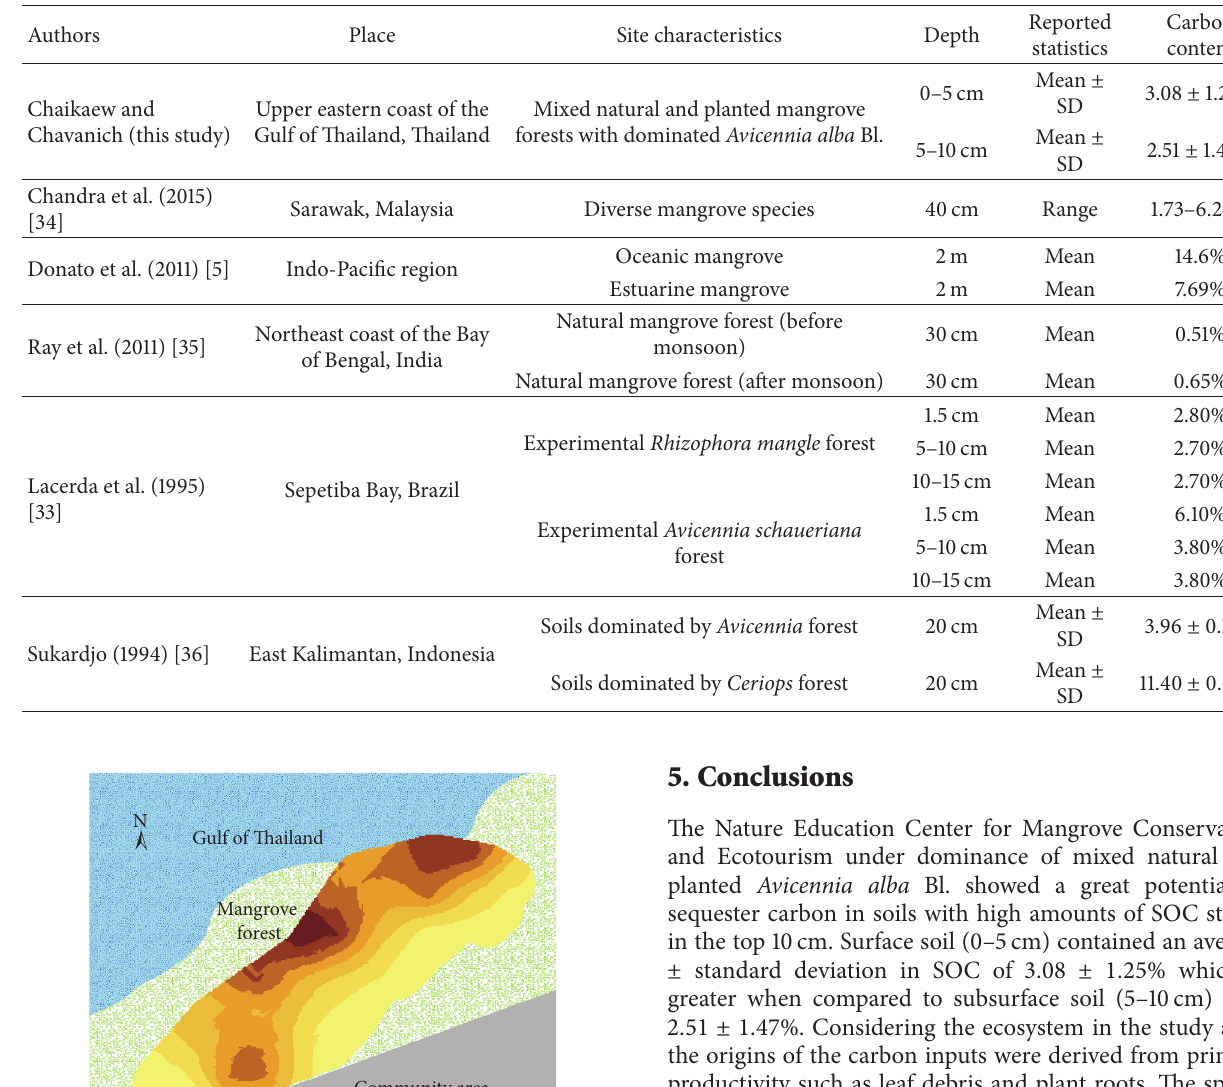
Table 3: Overview of available soil carbon content in mangrove forests.